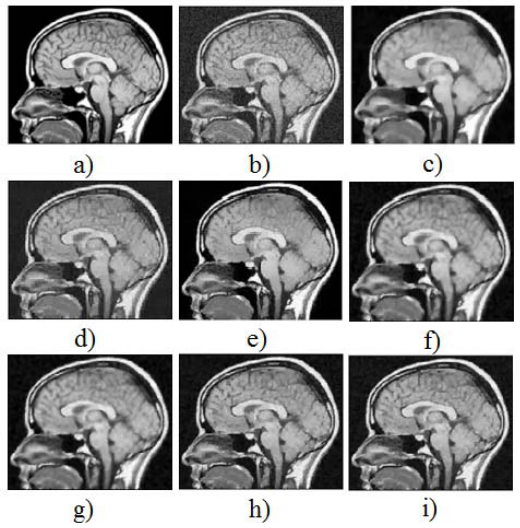
Figure 2. Original image (a); Gaussian noise image (b) with noise level 15  ; denoising results with TV (c),